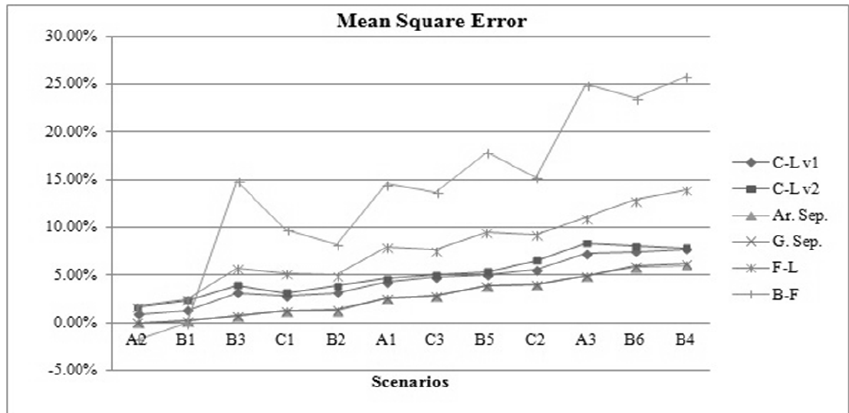
Fig. 3. Mean percentage error estimators produced by varying the temporal distribution of the number of settlements